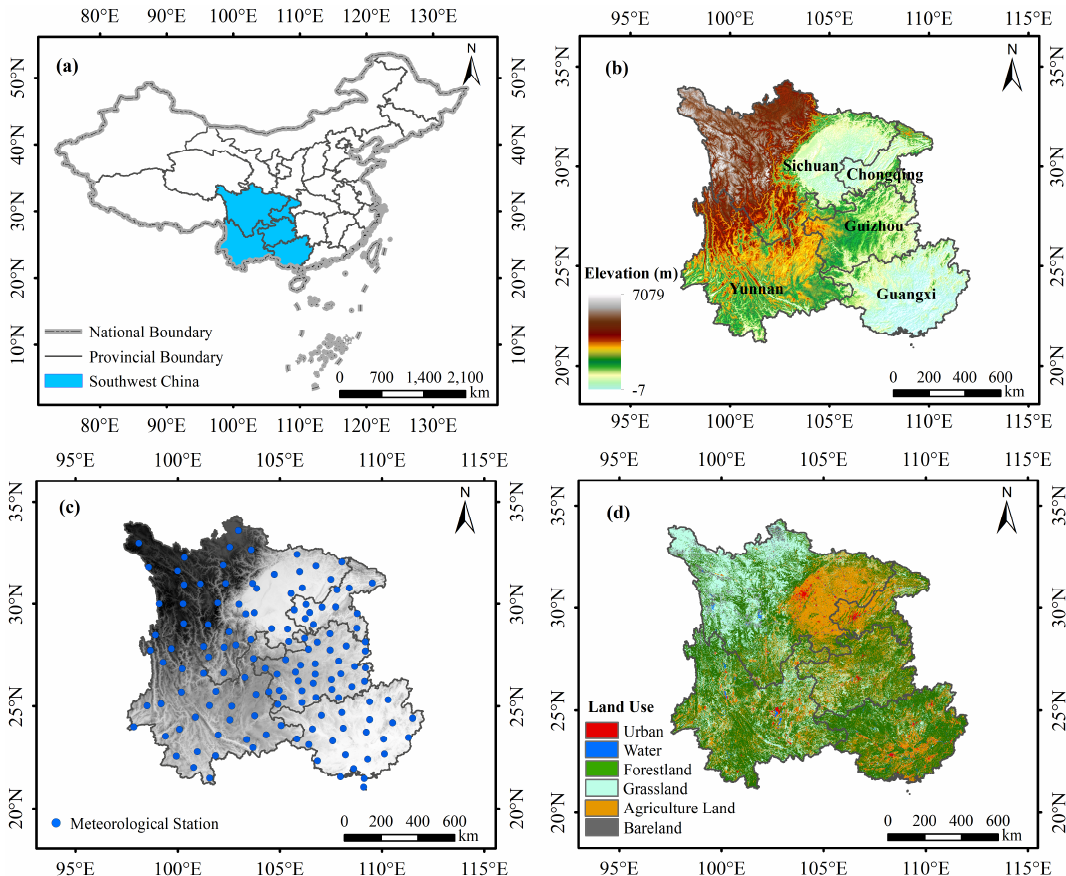
Figure 1. Information summary of Southwest China: ( a ) location; ( b ) elevation; ( c ) distribution of meteorological stations; ( d ) land use in 2018.